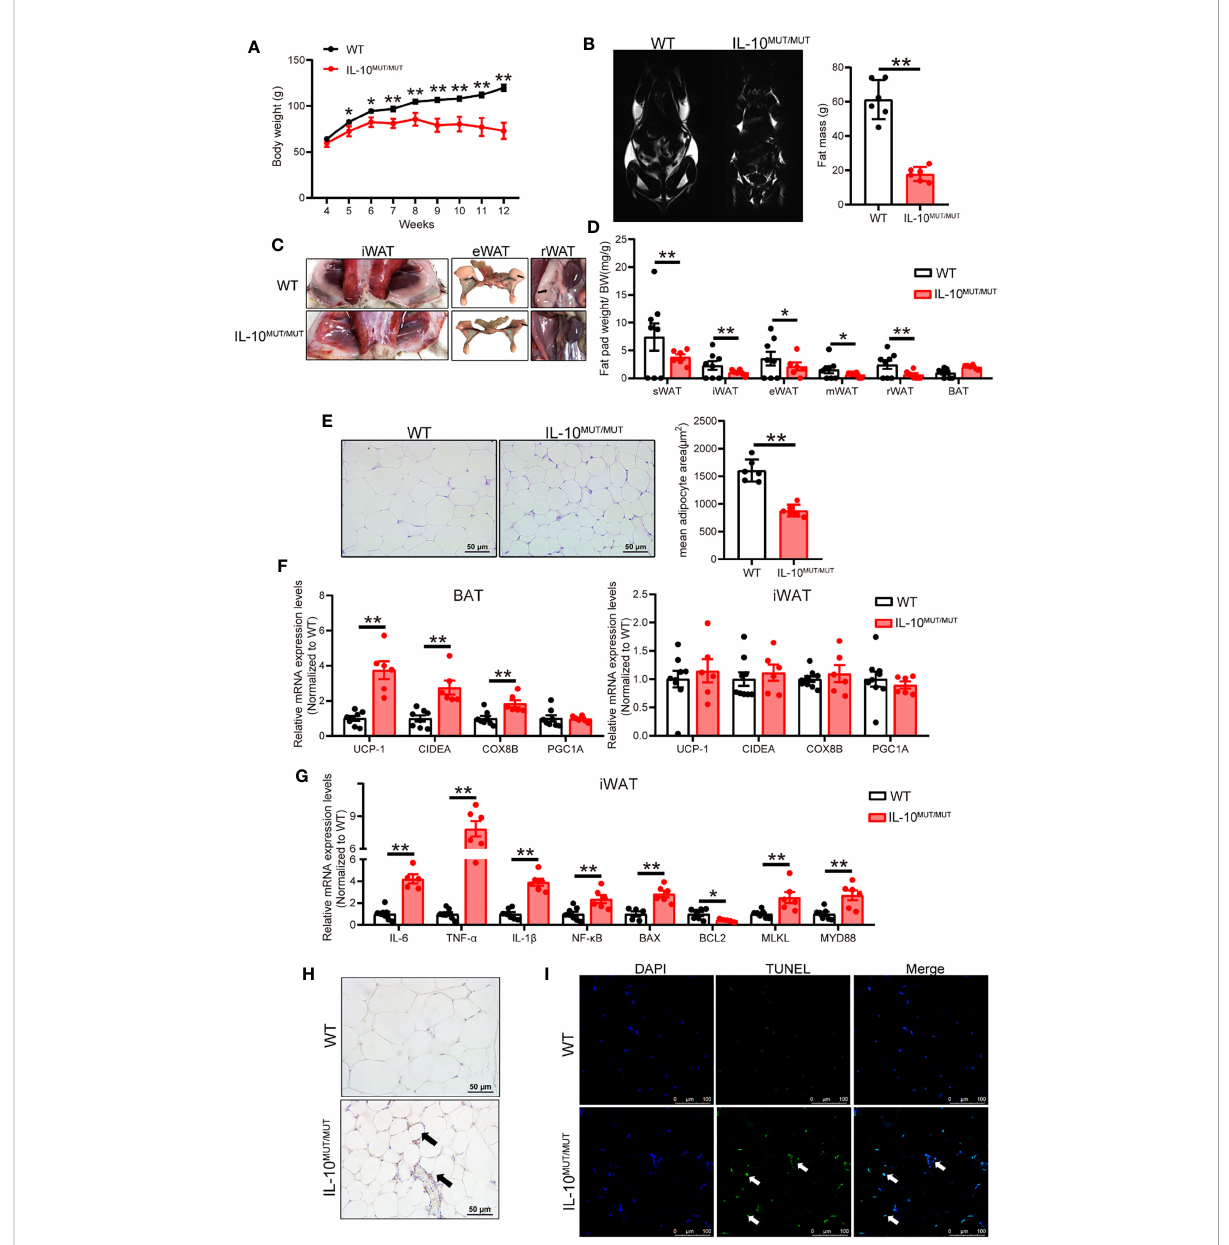
FIGURE 3 IL-10 de fi ciency caused severe white adipose tissue (WAT) dystrophy in chow-fed hamsters. (A) Body weight curve of WT and IL-10 MUT/MUT hamsters on chow diet (n=6/group). (B) Representative MRI images and total fat mass analyzed by MRI of 3-month-old male WT and IL-10 MUT/ MUT hamsters (n=6/group). (C) Representative images of iWAT, eWAT and rWAT from WT and IL-10 MUT/MUT hamsters. Arrows indicate WAT. (D) Analysis of the ratio of fat weight and body weight for different types of adipose tissues from 3-months old WT and IL-10 MUT/MUT hamsters (n=6~8/group). (E) Representative images of iWAT (left) and quanti fi cation of adipocyte area (right) (n=6/group). (F) Expression levels of genes regulating thermogenesis in BAT (left) and iWAT (right) were determined by real-time PCR (n=5~7/group). (G) Expression levels of genes involved in in fl ammation and apoptosis in iWAT were determined by real-time PCR (n=5~7/group). (H) Immunohistochemistry of CD68 in the iWAT from WT and IL-10 MUT/MUT hamsters. Bars: 50 m m; arrows indicate positive staining. (I) TUNEL staining (green) in the iWAT from WT (top) and IL-10 MUT/MUT (bottom) hamsters. Nuclei were stained with DAPI (blue). Bars: 100 m m; white arrows indicate positive staining.All date were expressed as means ± SEM, *p<0.05;